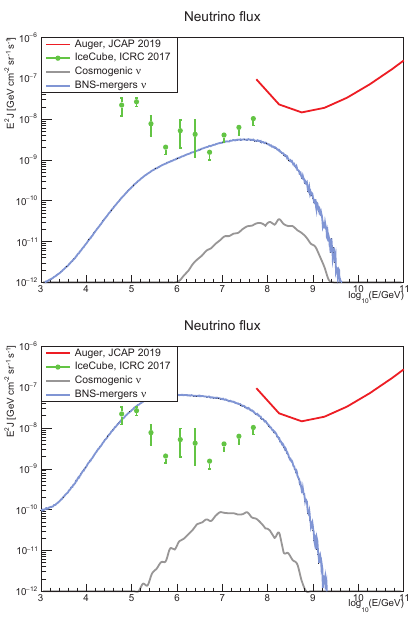
Figure 4. Expected BNS mergers and cosmogenic neutrino fluxes, with the measured flux by IceCube [12] and the limit for cosmogenic neutrinos by the Pierre Auger Observatory [13]. The expected neutrino fluxes refer to the following parameters of a pure-proton spectrum at injection and for a GW-like source class: γ = 1 . 5, R max = 10 18 V and m = 0 (top panel); γ = 1 . 5, = 10 18 V and m = 3 . 4 (bottom panel). R max